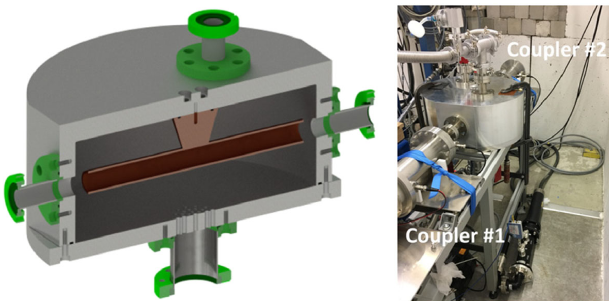
FIG. 3. Sectional drawing of the 15-gap demonstrator CH cavity.